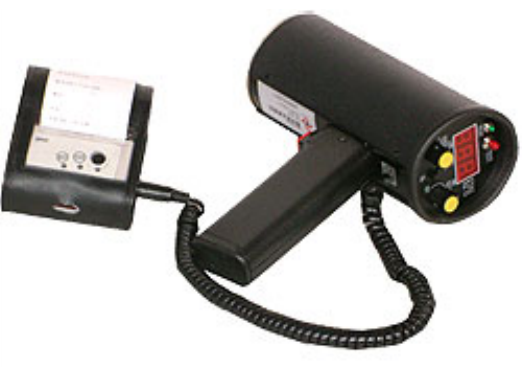
Figure 8. CSR-68 Speed radar